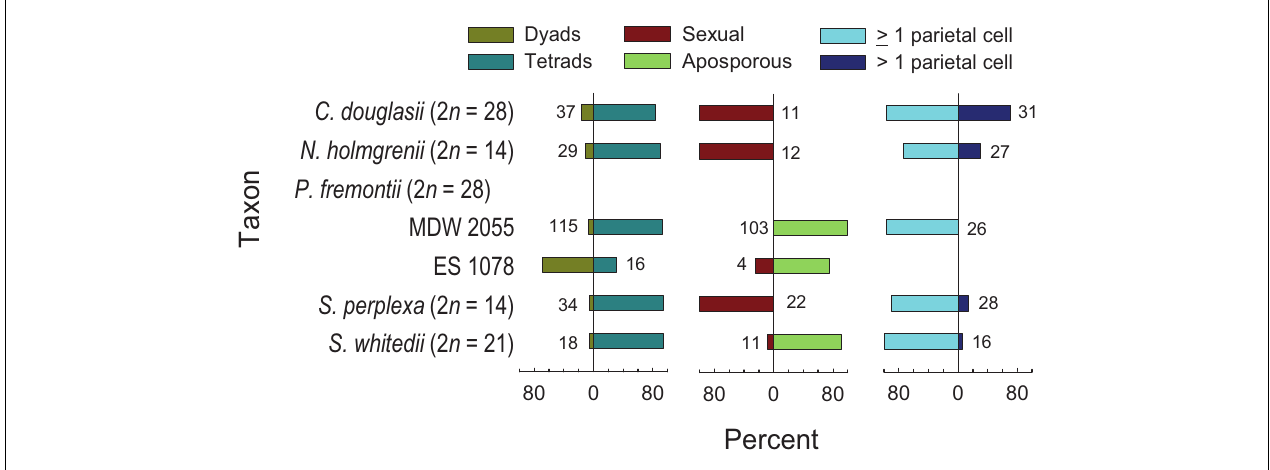
FIGURE 8 | Frequencies of dyads vs. tetrads, sexual vs. aposporous gametophytes, and parietal cells or tissues ( ≥ 1 parietal cell) vs. parietal tissues ( > 1 parietal cell). Numbers next to bars represent observations contributing to each variable pair.